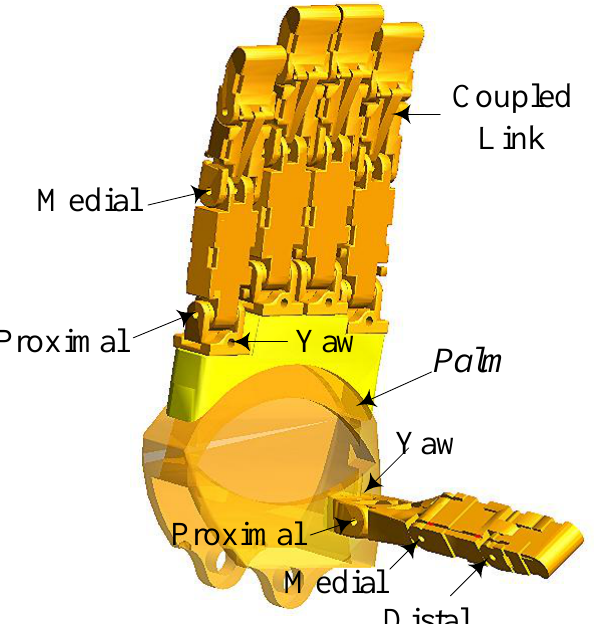
Figure 1. The model of the dexterous hand in